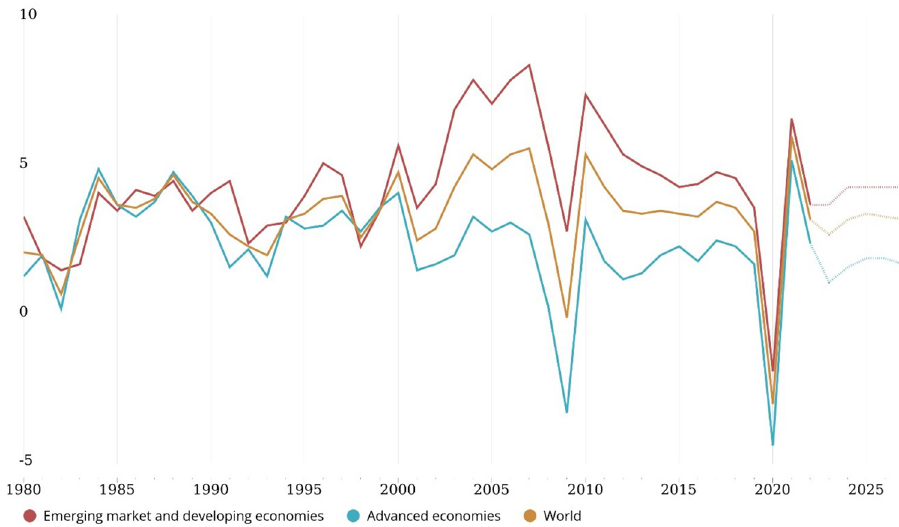
Fig 1. Real GDP annual growth (source: IMF, world economic outlook,